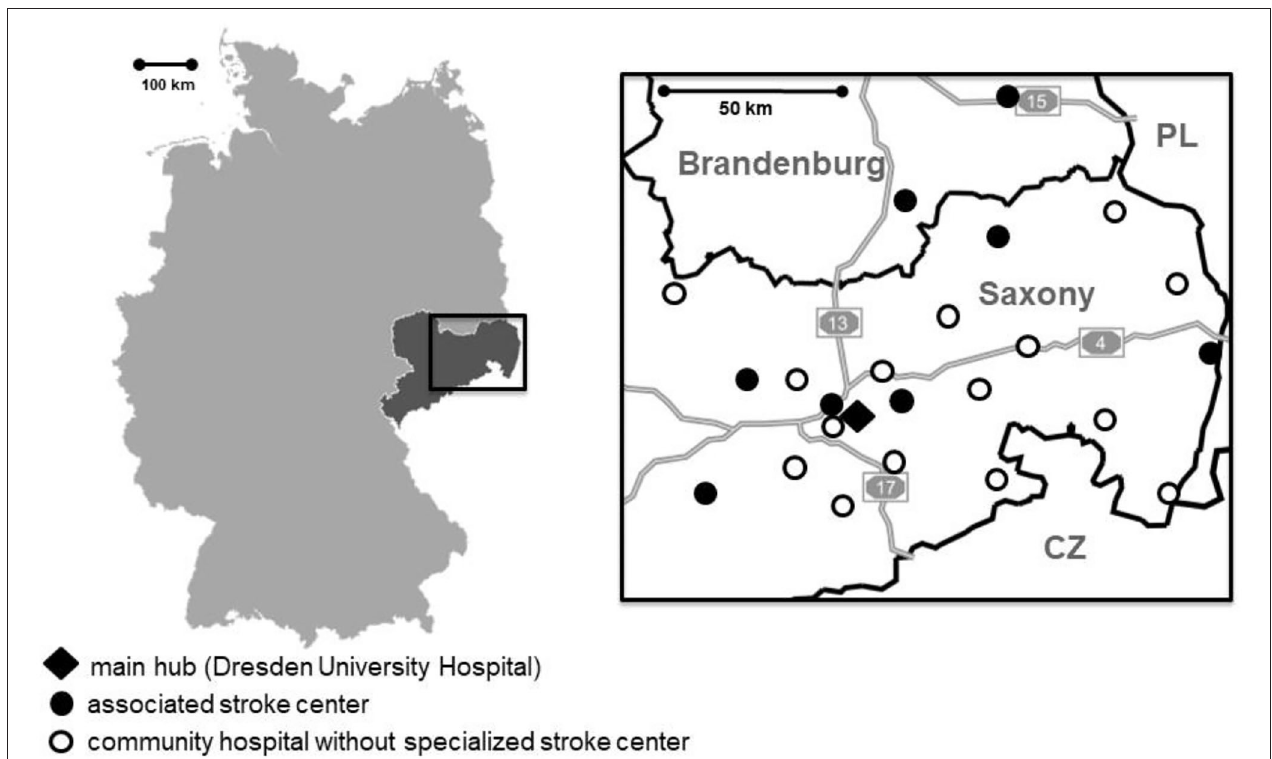
FIGURE 1 | Left: map of the Federal Republic of Germany; the state of Saxony is highlighted in dark gray. Right: Map of our telestroke network in Eastern Saxony and Southern Brandenburg; dark lines indicate state and country borders; light gray lines with numbers indicate federal highways ( Autobahn ); CZ indicates Czech Republic; PL,